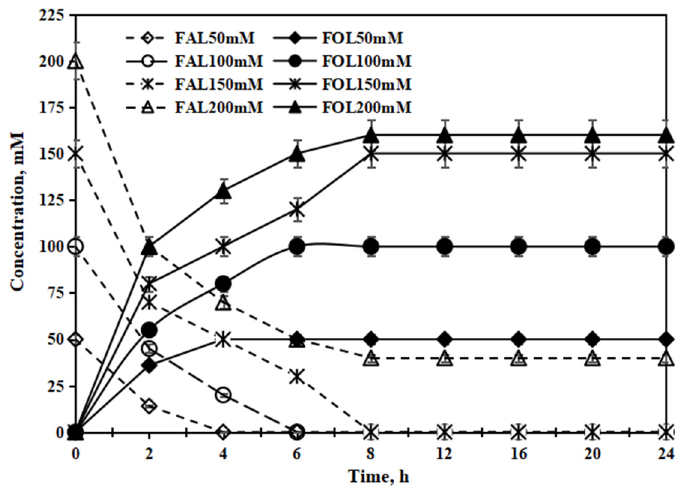
Figure 5. Time courses for the bio-reduction in D -xylose-derived FAL (50–200 mM) by whole cells in the presence of HCOONa (3.0 mol HCOONa/mol FAL).